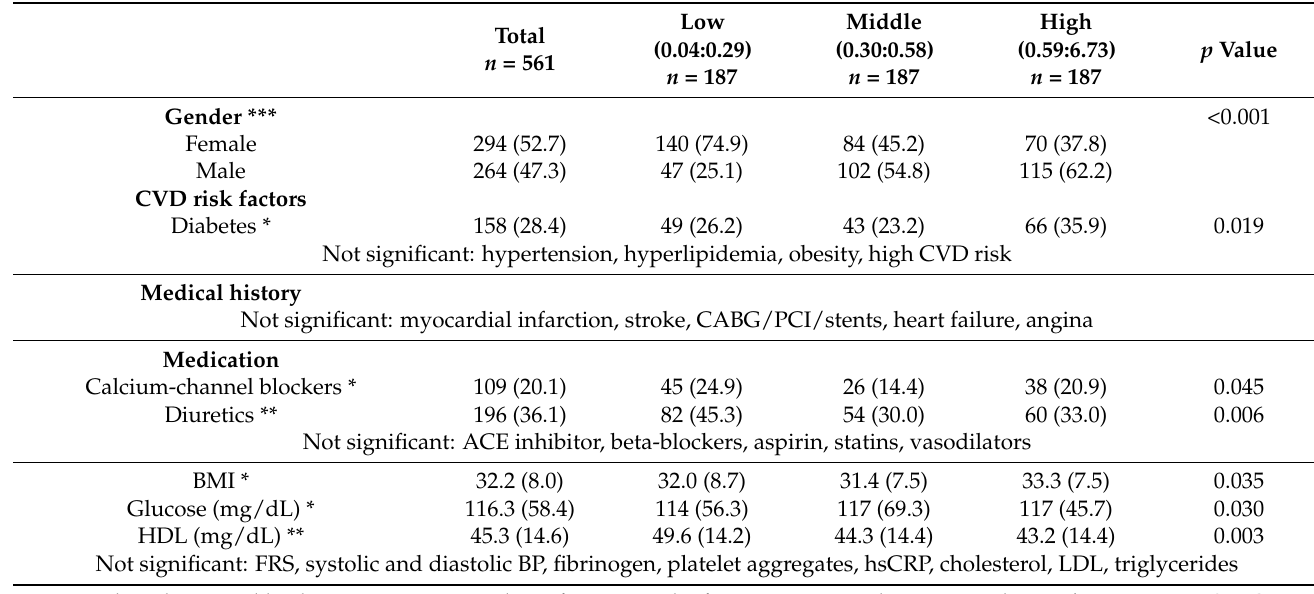
Table 3. Characteristics of Study Participants Stratified by Urinary Levels of